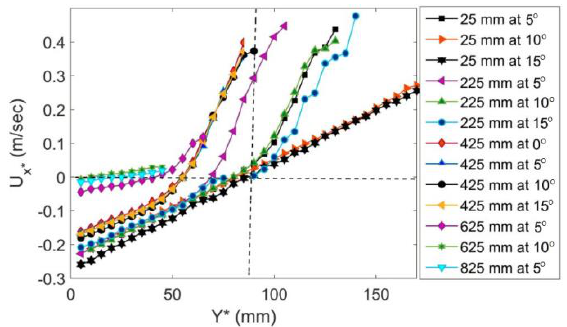
Fig. 4. Distributions of velocity U x* along the Y* axis at different locations for different angles of